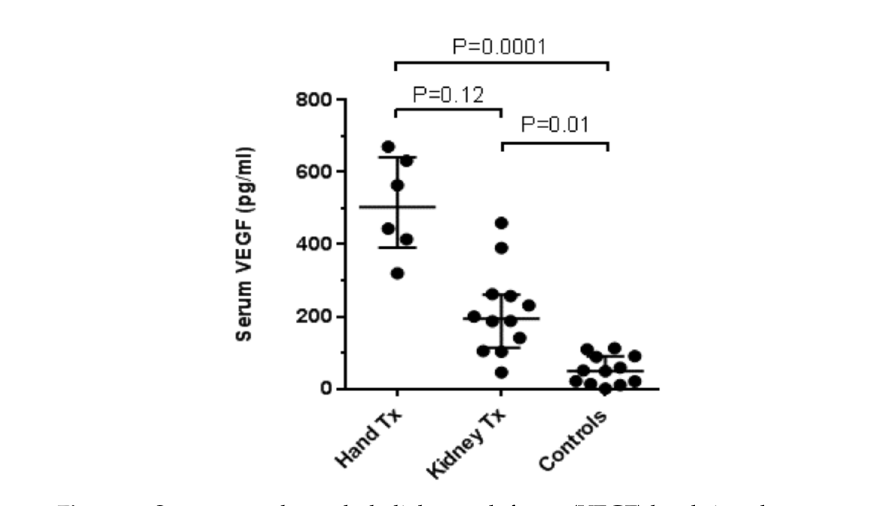
Figure 2. Serum vascular endothelial growth factor (VEGF) levels in subgroup.